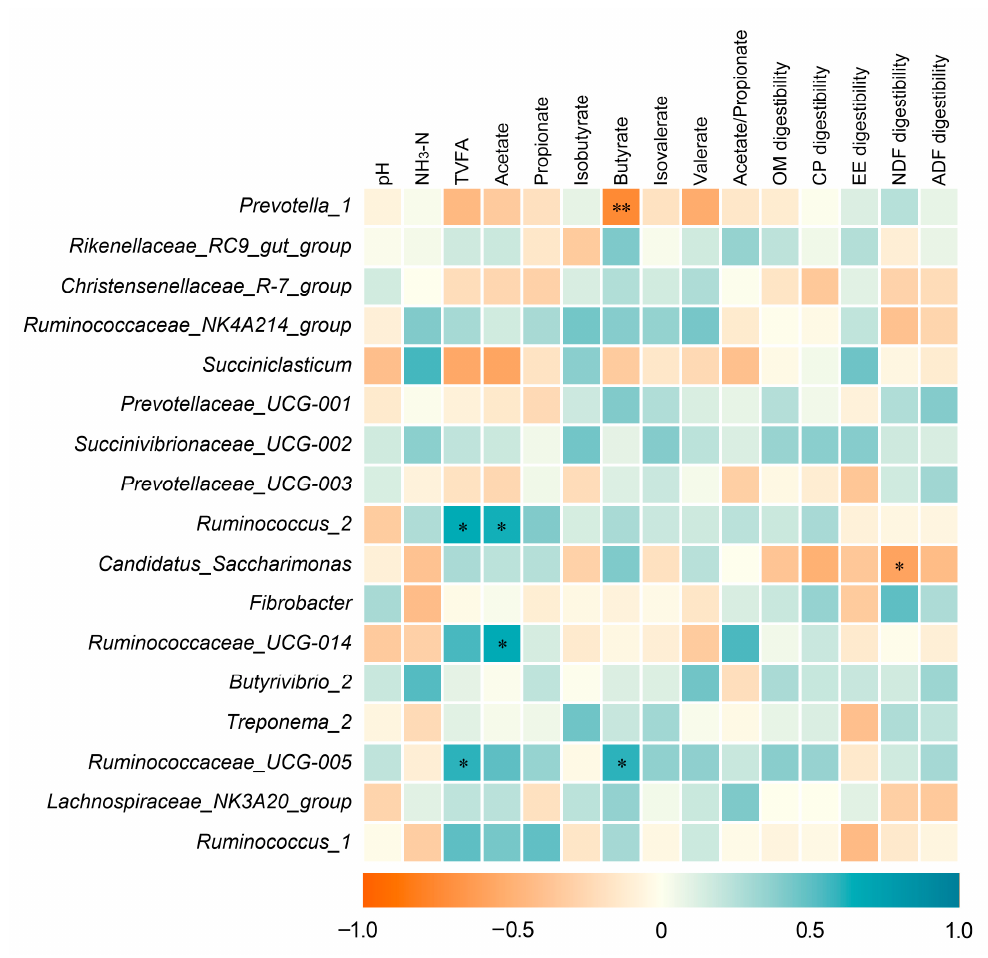
Figure 2. Correlation between fermentation products, nutrient digestibility, and rumen bacteria. The genera representing at least 1% of the bacterial community are presented. The blue lattices denote that the correlation is positive (closer to 1), and the red lattices denote that the correlation is negative (closer to − 1) between ruminal bacteria and fermentation parameters. * p < 0.05; ** p < 0.01.